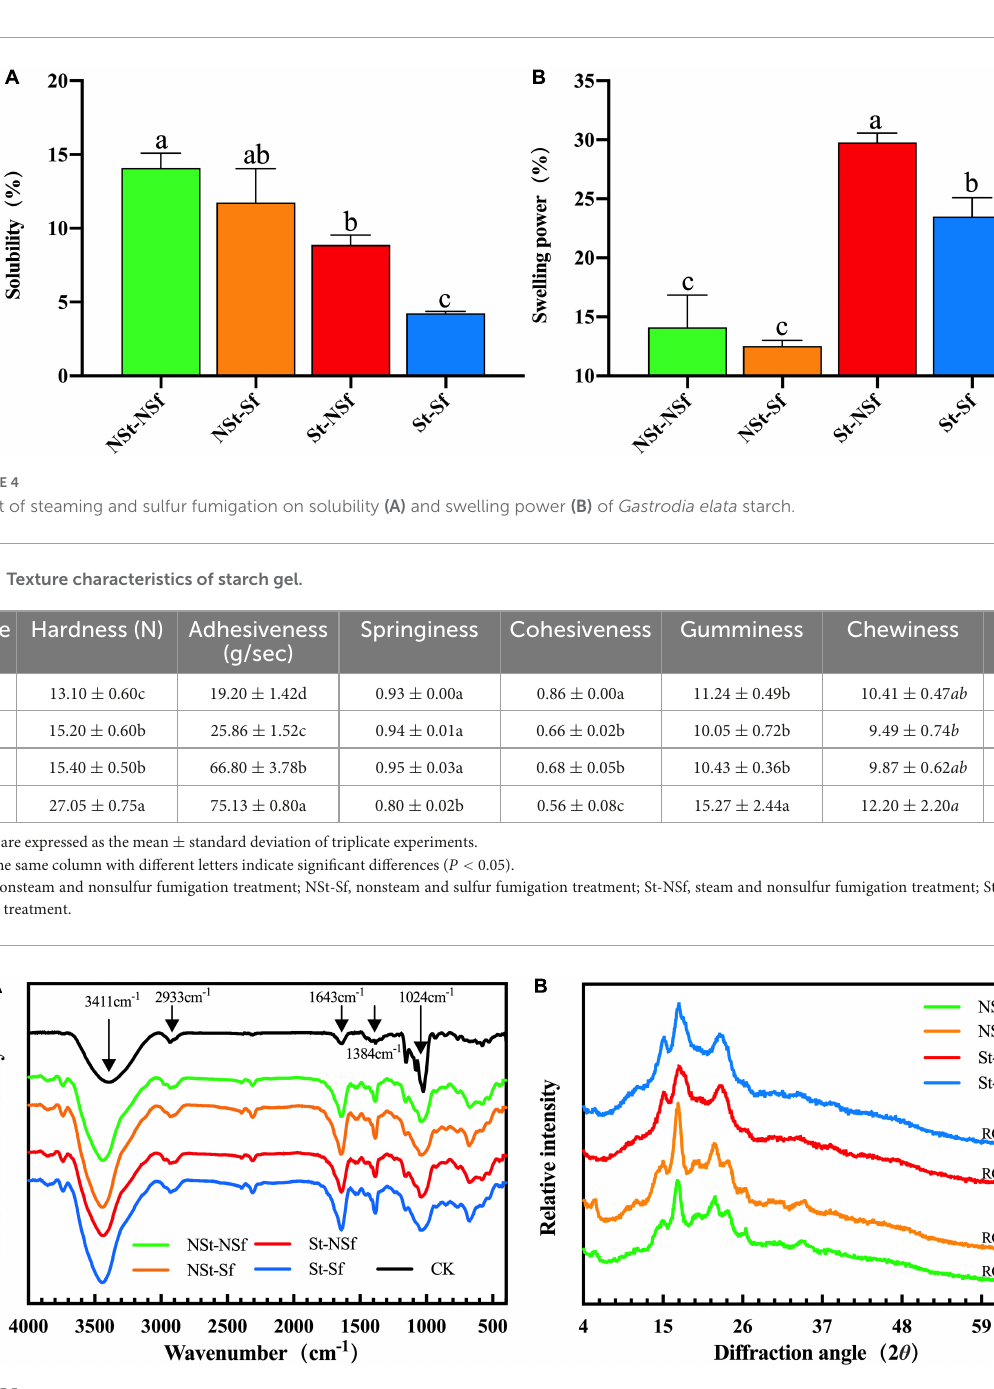
is caused by the evaporation of crystal water in starch, while the second stage is attributed to the decomposition of